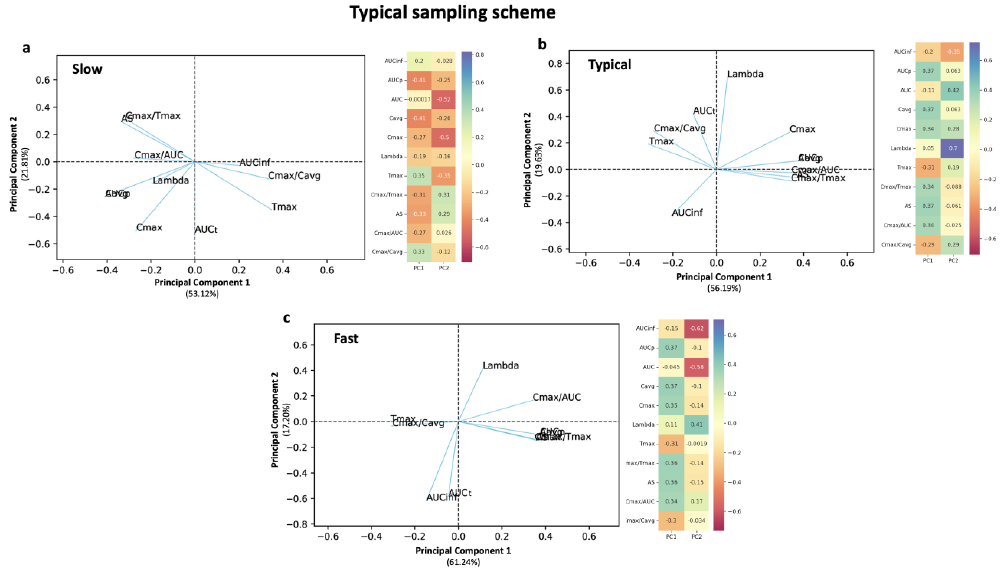
Figure A3. Principal component analysis for the pharmacokinetic parameters estimated from the simulated bioequivalence studies when a typical sampling schedule (see Table 2) was utilized. The results refer to the three simulated conditions of slow 0.5 × ( a ), typical 1 × ( b ), and fast 2 × absorption ( c ). The terms 0.5 × , 1 × , and 2 × refer to the number of times the absorption rate constant used in simulations is greater or less than the one observed in actual data. Left panel: Biplot of the two principal components displaying the individual scores and the loadings (blue lines). Right panel: Loading values in the case of the first and second principal components (PC1 and PC2). A description of the pharmacokinetic parameters is provided in Table